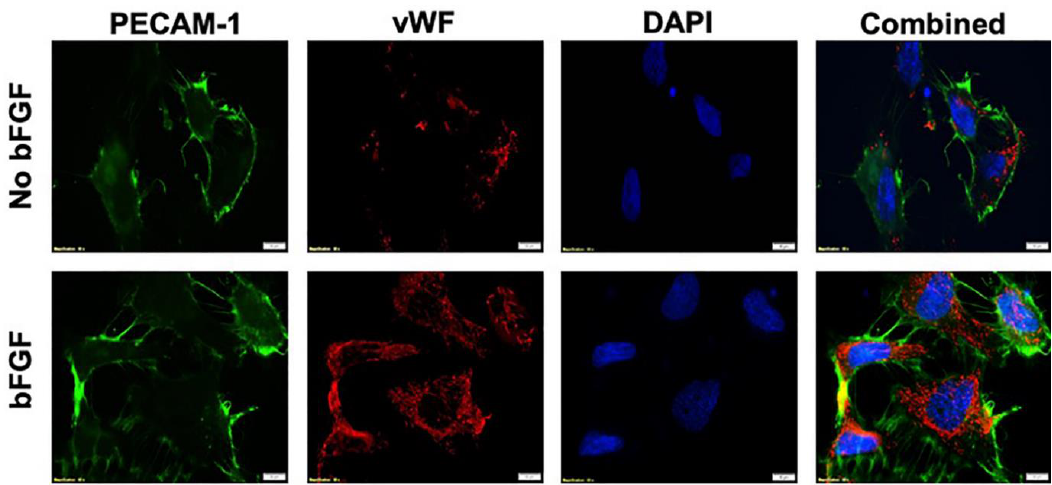
Figure 2. Immunostaining of angiogenic markers in Human Umbilical Vein Endothelial Cell line (HUVECs). Cells were stained with Platelet Endothelial Cell Adhesion Molecule-1 (PECAM-1) (green), vWF (red) and nucleus with DAPI (blue). The expression of PECAM-1 and von Willebrand Factor (VWF) is evident in HUVECs regardless of basic Fibroblast Growth Factor (bFGF) exposure.